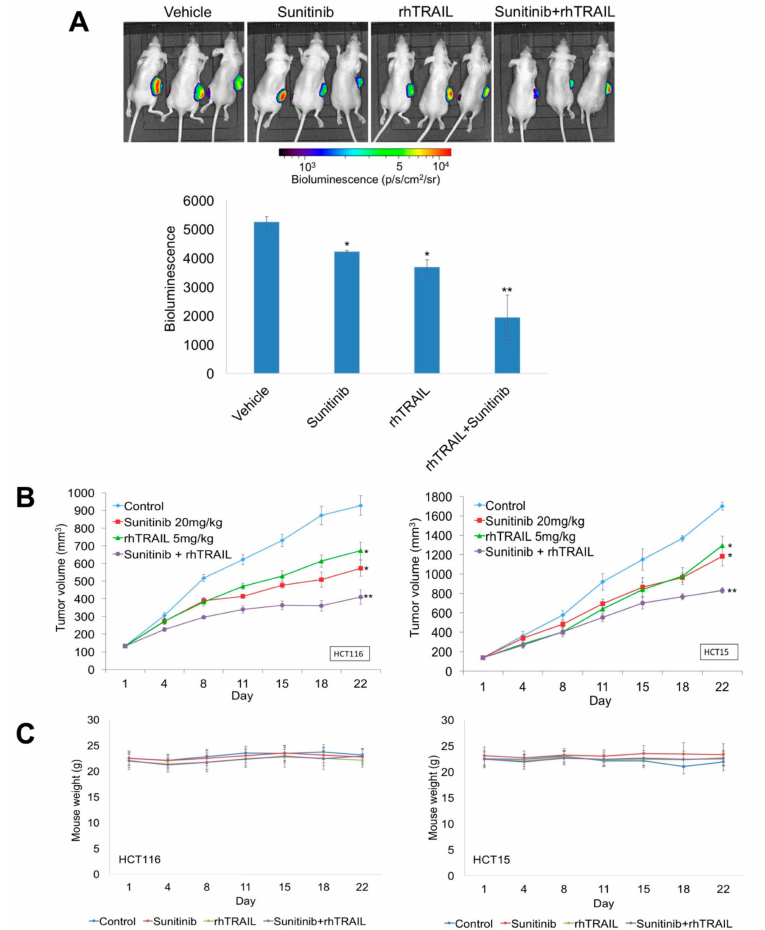
Figure 5. Sunitinib and recombinant human tumor necrosis factor-related apoptosis-inducing ligand (rhTRAIL) reduce tumor burden in colon cancer xenografts. ( A , B ) HCT116-luc and HCT15 colon cancer cells were injected s.c. into the flanks of nude mice. Mice with palpable tumors were randomized into groups of 10 and were treated with 20 mg / kg sunitinib orally (PO), 5 mg / kg rhTRAIL intraperitoneal (IP), or both agents daily for 5 days a week for 3 weeks. HCT116-luc tumor-bearing mice were imaged on Day 22. Tumor volume was measured twice weekly throughout the study. Mean ± standard error of the mean (SEM), n = 10. * Indicates a significant di ff erence compared to vehicle control or ** compared to either single agent group, p < 0.05. ( C ) Drug treatments were well tolerated. Mouse weights were measured twice per week. Mean ± standard deviation (SD), n =